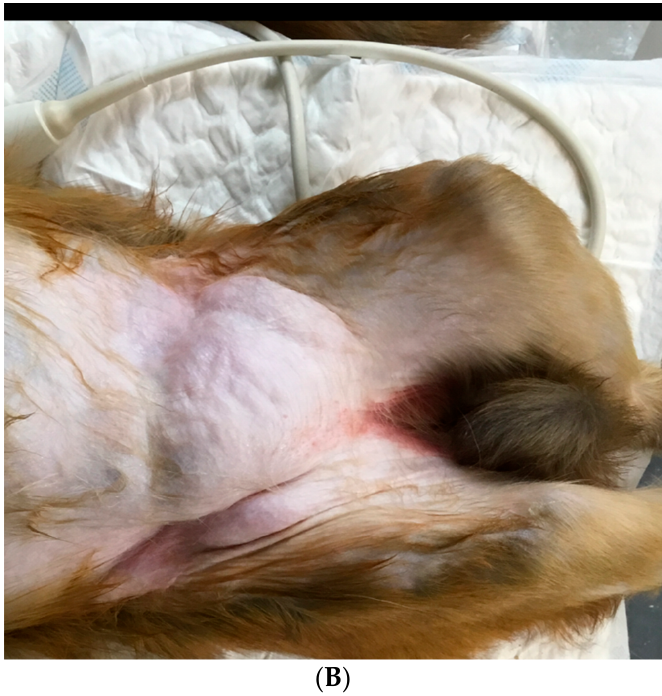
Figure 1. ( A ) Several examples of inguinal hernias observed during physical examination in male rhesus monkeys (photographs provided by Biomedical Primate Research Centre); ( B ) example of an inguinal hernia in a female rhesus monkey. Hernias are present in both left and right inguinal regions (photographs provided by Biomedical Primate Research Centre).